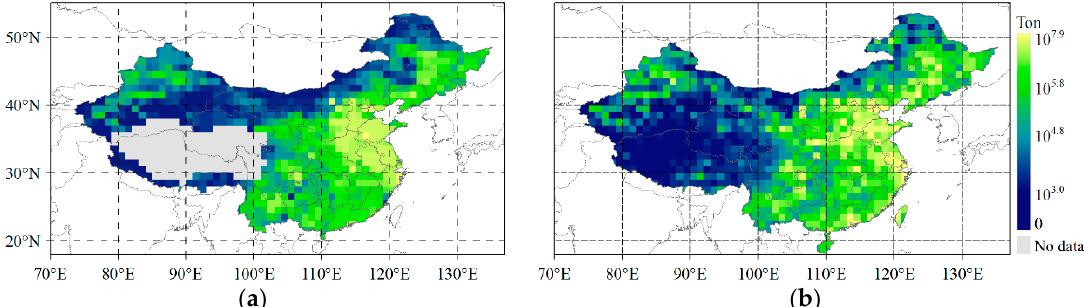
Figure 4. The anthropogenic CO 2 emissions in 2015 in China: ( a ) CO 2 emission estimated using GRNN based on the annual dXCO 2 in 2015 from GOSAT observations. The Tibet area shown as blank is filtered due to their high uncertainty XCO 2 retrievals; ( b ) the CO2 emission from ODIAC in 2015.